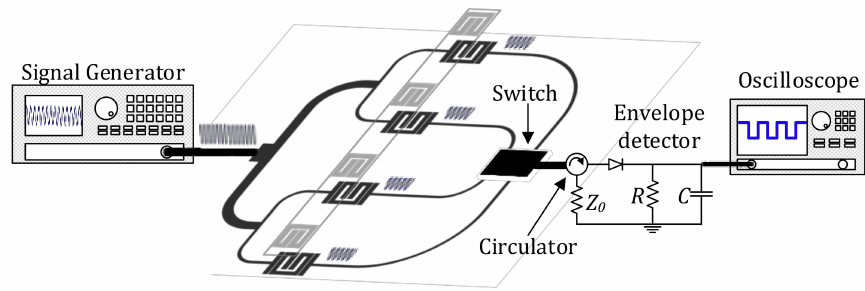
Figure 1. Sketch of the proposed chipless radio-frequency identification (RFID) sensing and identification system. The envelope detector is preceded by a circulator (configured as an isolator) in order to avoid mismatching reflections from the diode (a highly nonlinear device). To ensure proper alignment between the reader and the tag, a guiding system may be used.